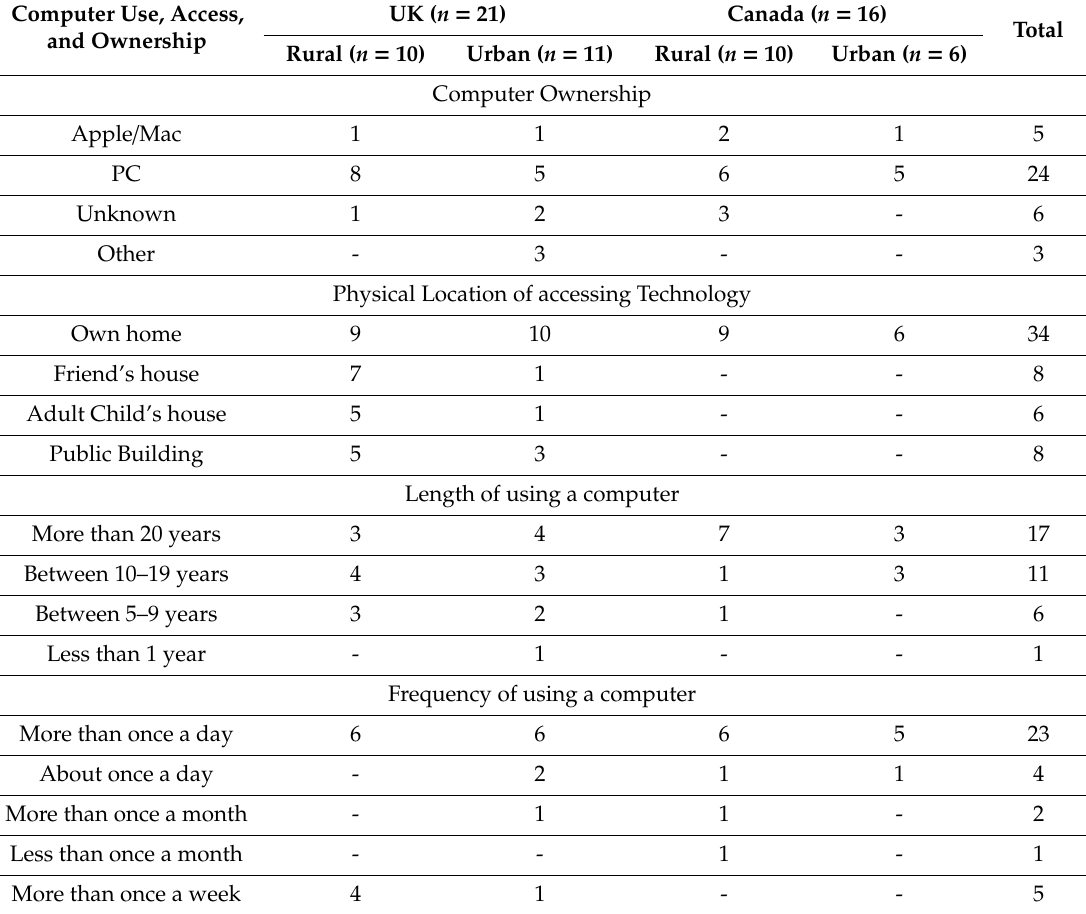
Table 2. Type of computer used, location of use, and length of time used a computer by country (UK and Canada) and location (rural and